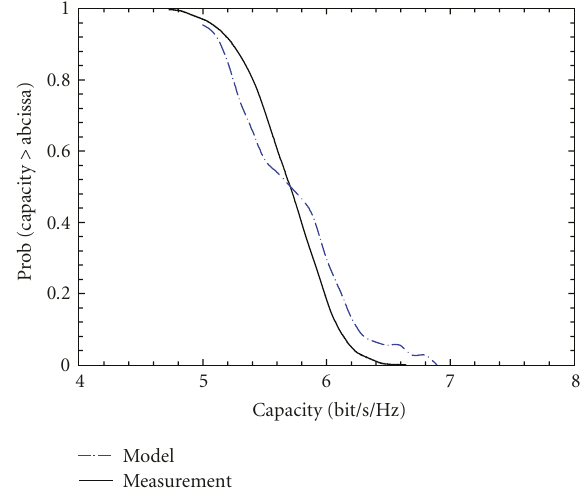
Figure 11: Application of the MIMO model for a 4 × 4 MIMO system, for a frequency of 4GHz and for a distance of 250